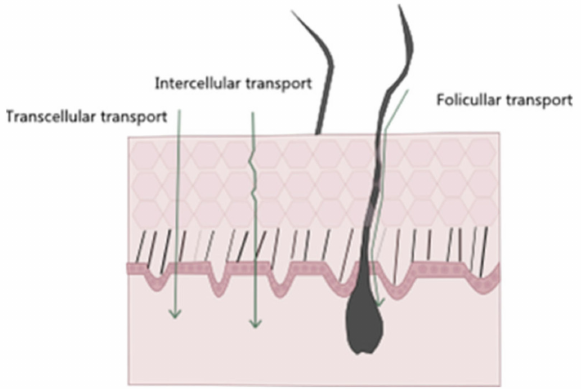
Figure 3. Schematic representation of different entry pathways for molecules into the